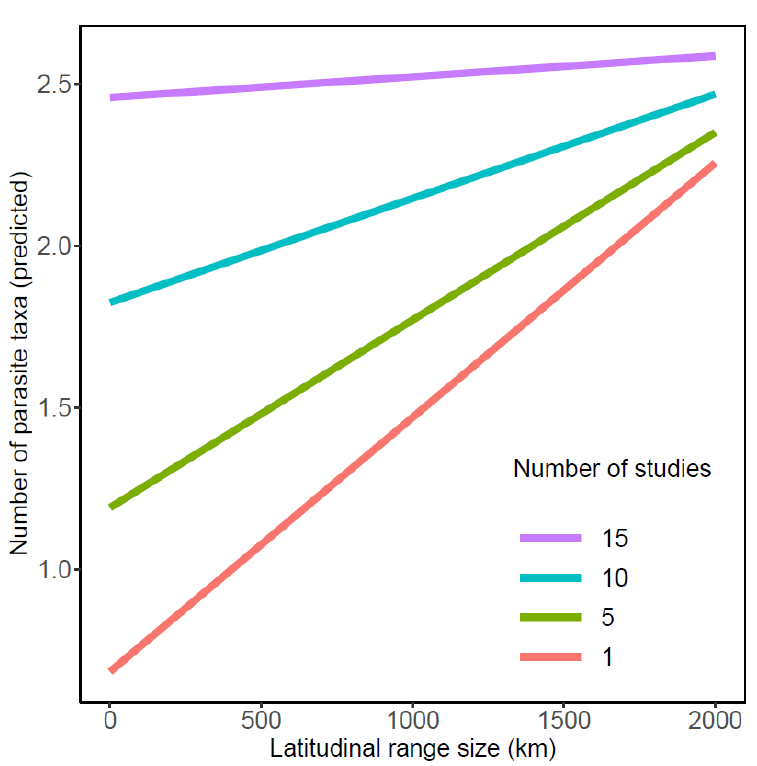
Figure 1. Influence of the ( a ) number of studies (log scale) and ( b ) latitudinal range size (km) on the number of parasite taxa reported for each galaxiid species per geographic region.